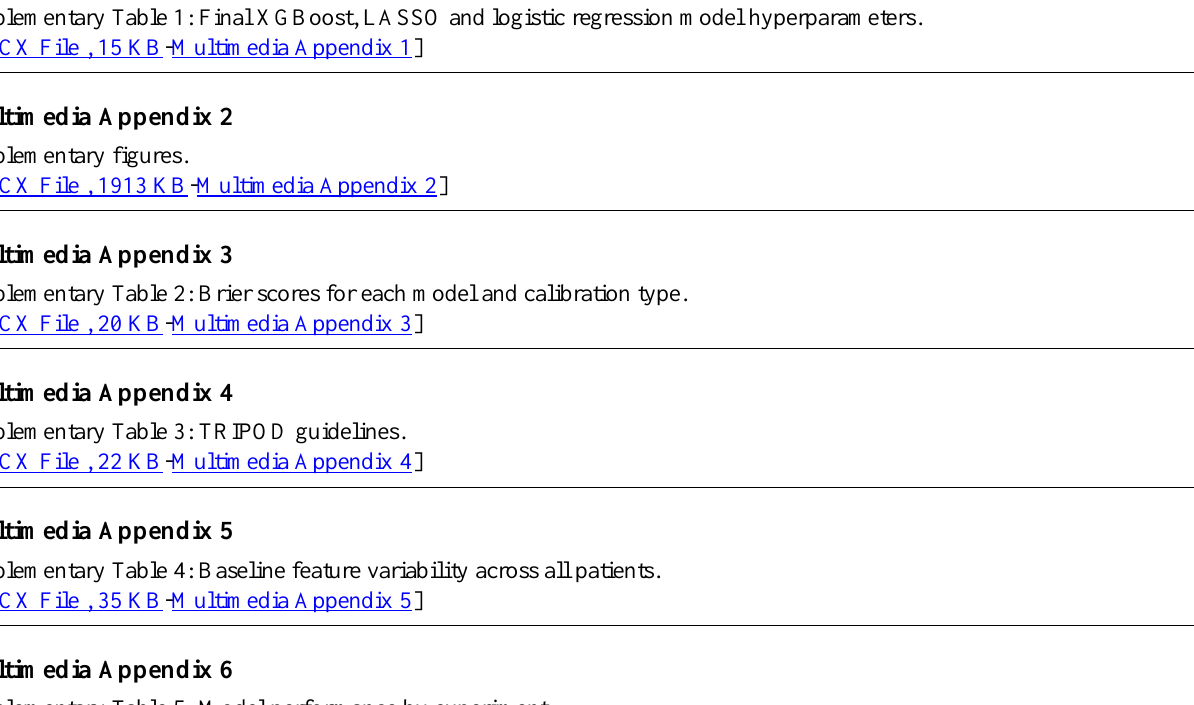
Supplementary Table 5: Model performance by